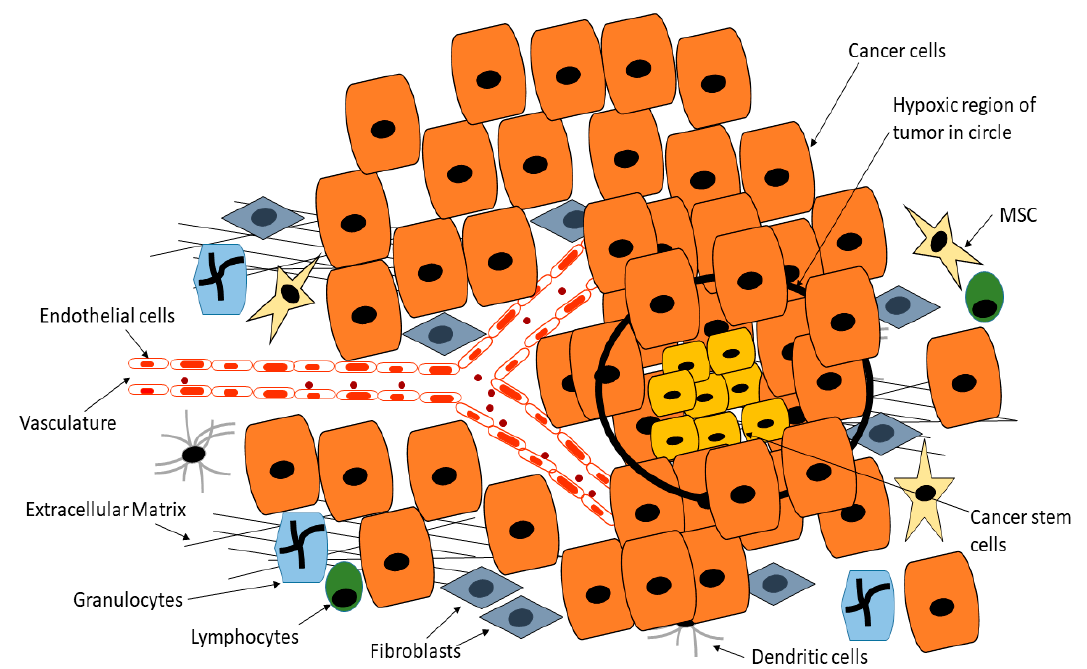
Figure 4. Cancer stem cells are able to reside deep within the tumor in hypoxic regions that are normally toxic to normal cells, whilst CSCs are able to release factors such as hypoxia-inducible factor 1 which induces the release of proangiogenic factors, this position means CSCs are inaccessible to drugs or are exposed to reduced drug doses. Adapted from Senthebane et al. [3].